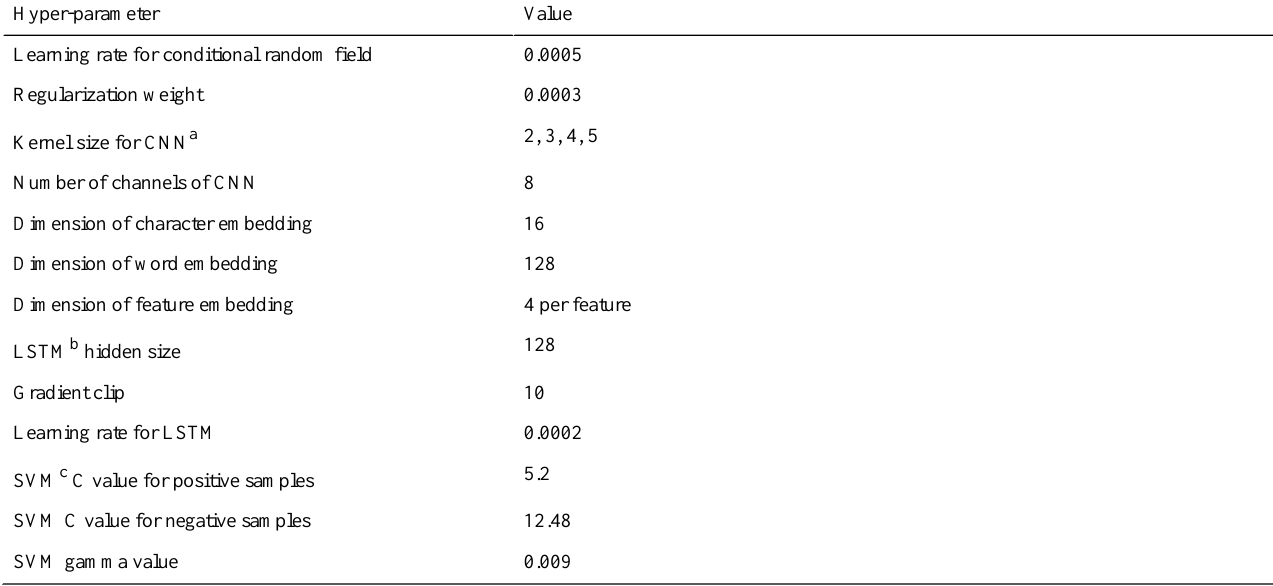
Table 3. The hyper-parameters